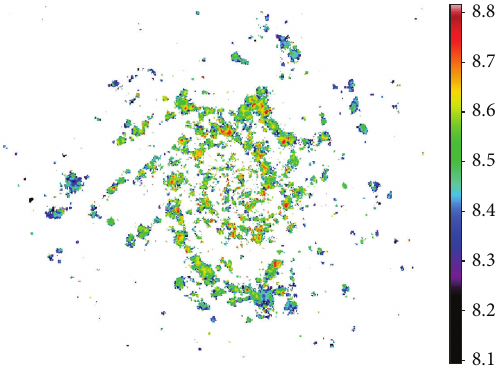
Figure 9: Pixel-by-pixel metallicity map using O3N2 indicator from PP04. FOV is 12 󸀠 × 12 󸀠